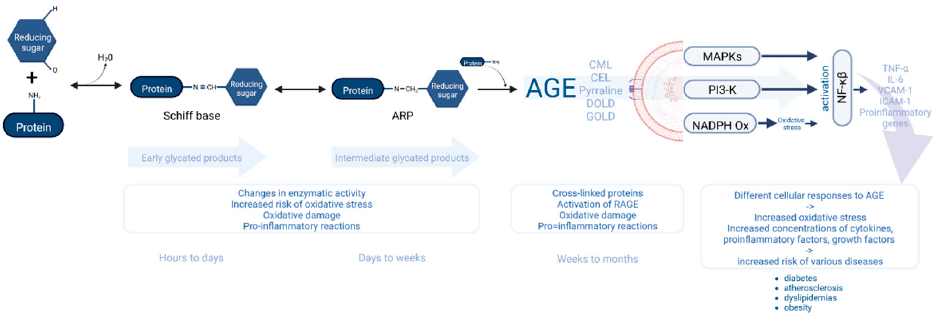
Figure 1. The mechanism involved in the relationship between the accumulation of protein glycation end products and cellular defense systems. end products and cellular defense